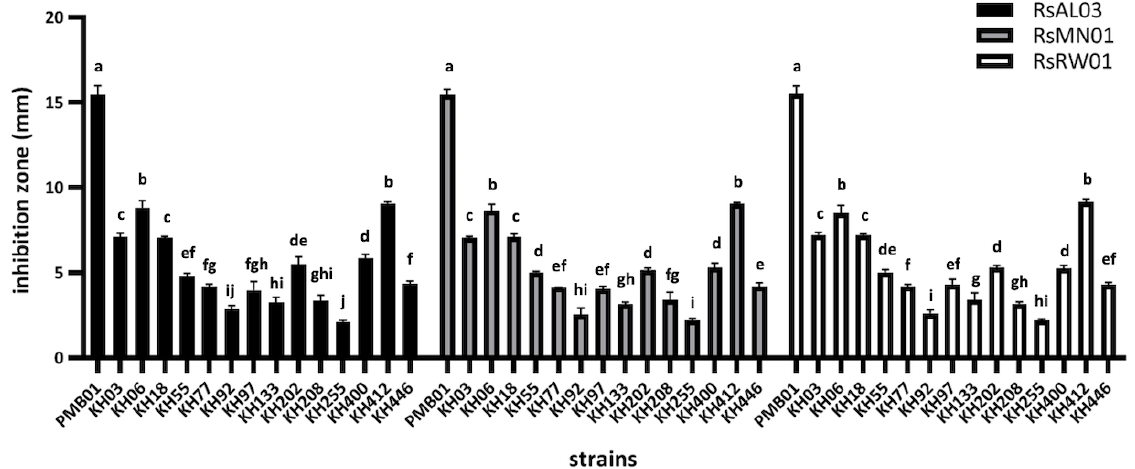
Figure 1. Antagonistic effects of 15 Bacillus amyloliquefaciens strains against three Ralstonia solanacearum strains evaluated by forming an inhibition zone (mm) on a triphenyl tetrazolium chloride medium (TTC). Means within the columns followed by different letters are significantly different according to Tukey’s HSD test ( p < 0.05).